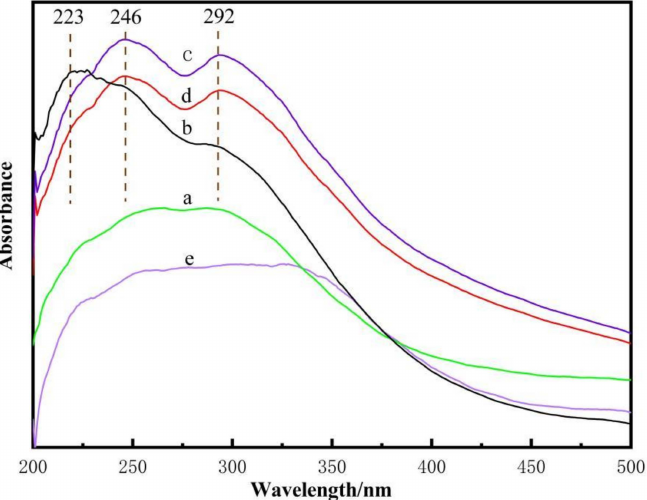
Figure 4. Diffuse reflectance ultraviolet–visible (UV–Vis) spectra of pure ZSM-5 ( a ) and composite products with different Zn/Si ratios Zn-ZSM-5 n(Zn)/n(Si) of: ( b ) 1:200; ( c ) 1:100; ( d ) 1:50; ( e ) 1:25.